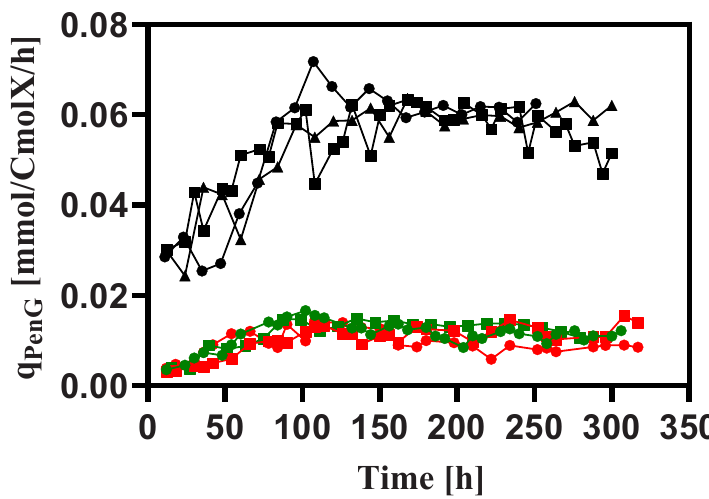
Figure 5. The biomass specific penicillin production rate during rapid feast/famine conditions throughout the chemostat phase. The symbols in black, red and green denote the results obtained from Penicillium chrysogenum Wisconsin 54-1255, Penicillium chrysogenum ∆ tps1 and Penicillium chryso- genum ∆ tps2 , respectively. Time 0 represents the start-up of chemostat cultivation.